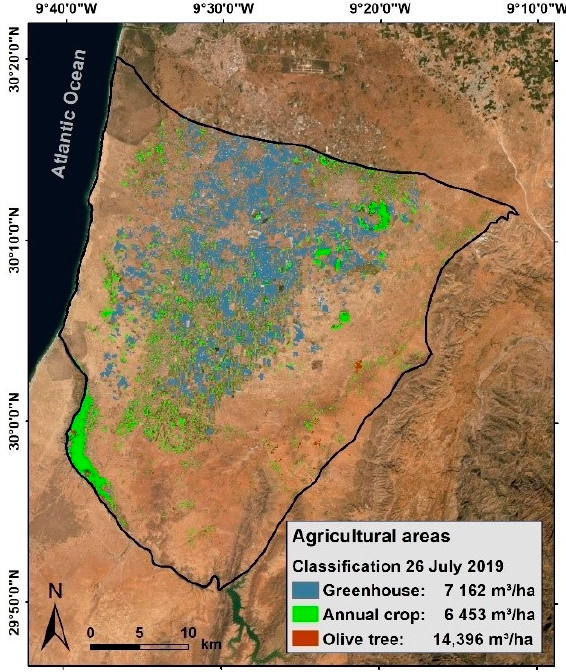
Figure 3. Average groundwater abstraction in summer 2019.